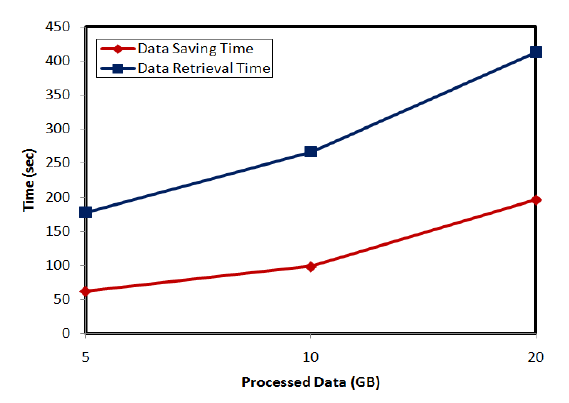
Figure 7. Data storage and retrieval time